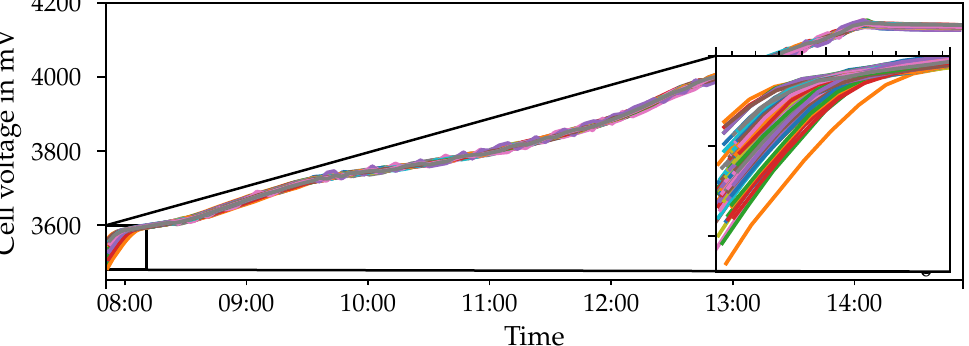
Figure 5. Charging measurement of all cells in the vehicle. Due to cell rotation, we record each cell once every 250s. We can see that in the lower SOC region deviations are highest.